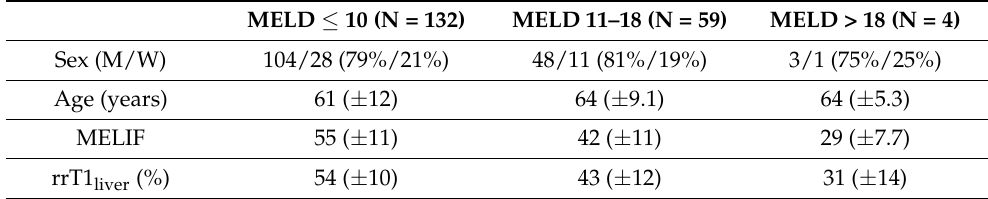
Data are presented as N (%) for categorical variables and the mean ( ± standard deviation) for continuous variables. MELD = model for end-stage liver disease.